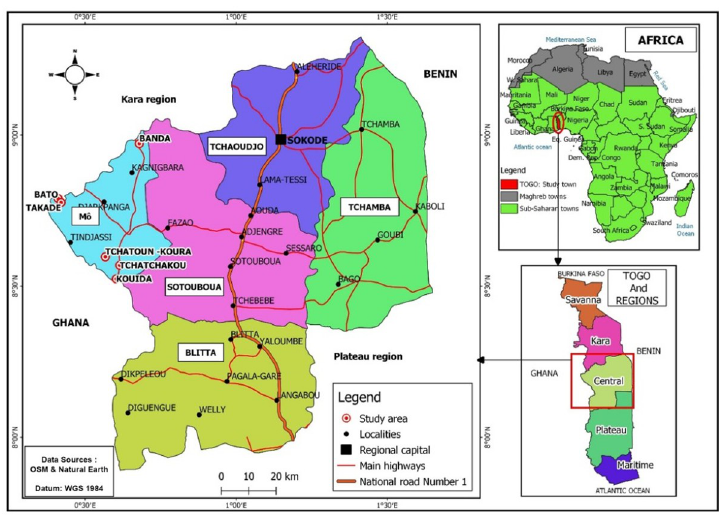
Fig 1. Map of Togo showing the six villages (study area) of the “Pre´fecture de Moˆ” in the Central region. Maps were adapted from: